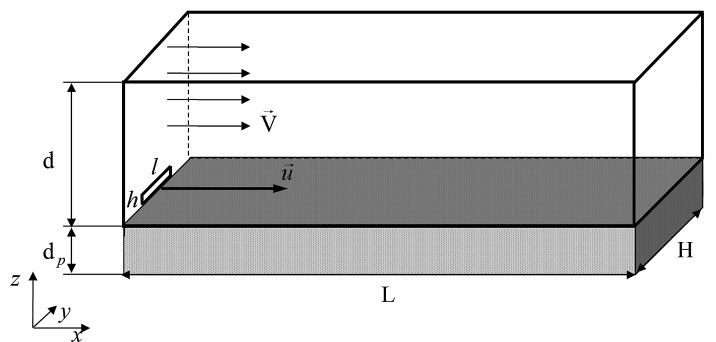
Figure 1. Geometry of the computational domain containing a culvert pipe in the form of a slot located near the bottom.